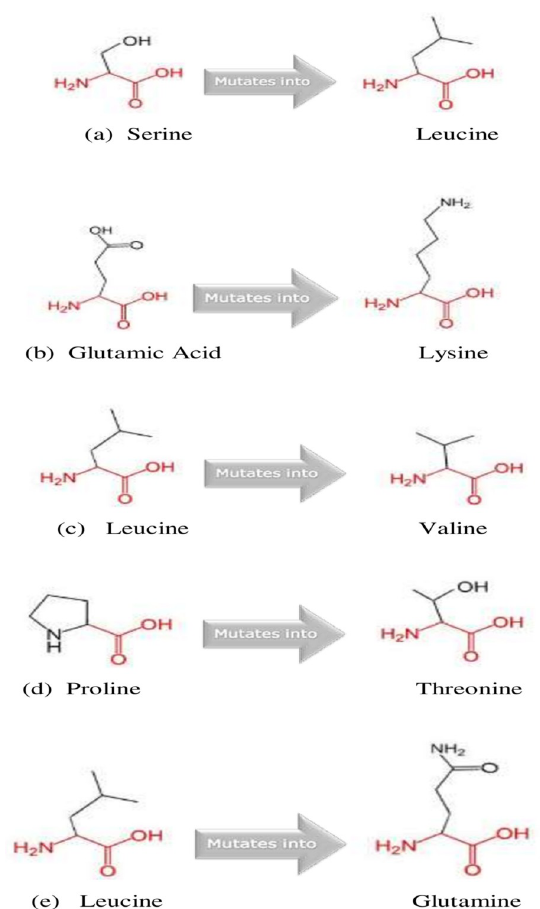
Fig 3. Schematic structures of the original (left) and the mutant (right) amino